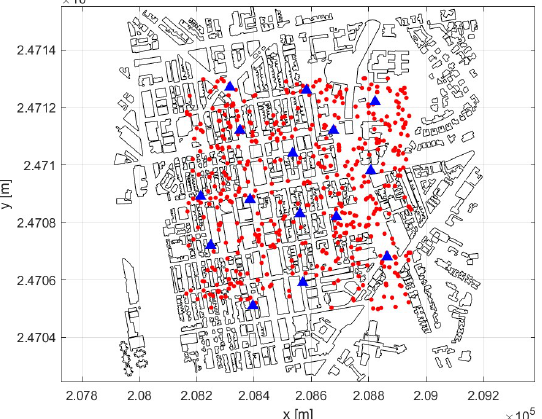
Figure 15. Survey points (red dots) and BSs (blue triangles) simulated with the ray tracer.